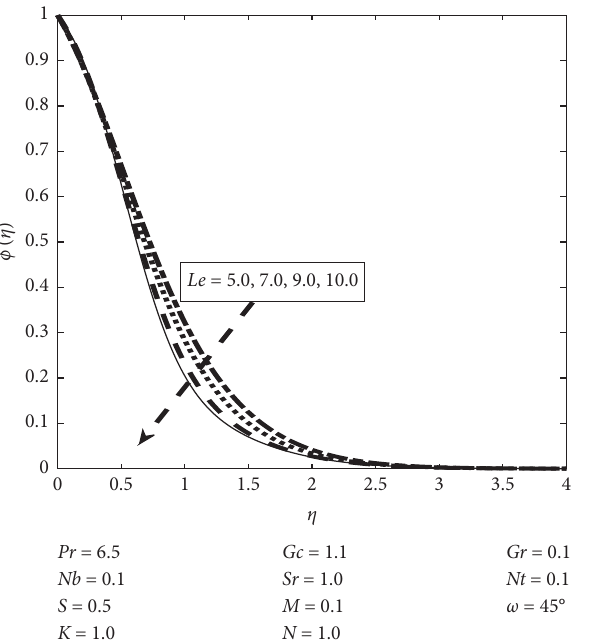
Figure 19: Variations of reduced Nusselt number with Nb for different values of ω .